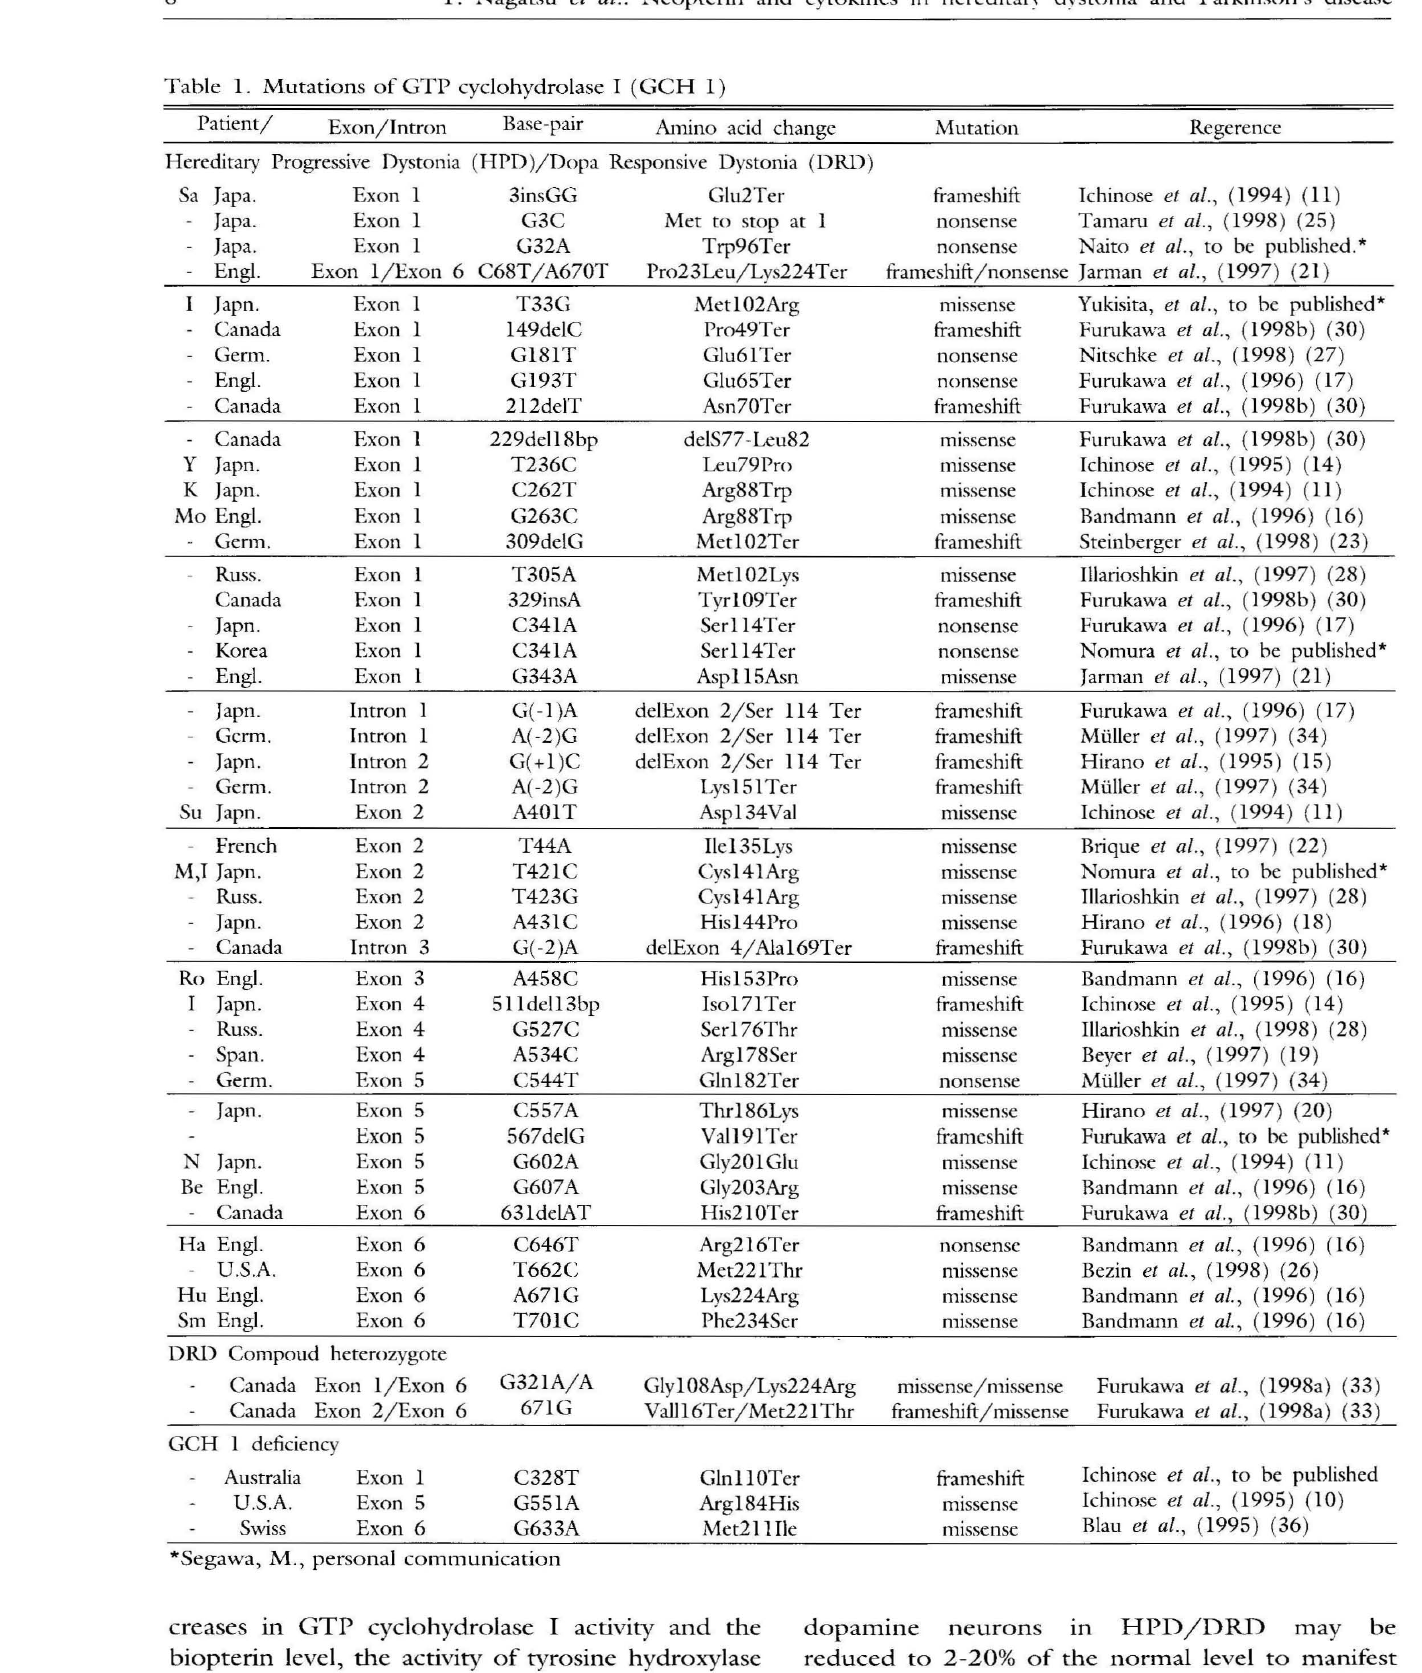
Table 1. M utations of GTP cyclohydrolase I (GCH 1) Patient/ Hereditary Progressive Dystonia (HPD)/Dopa Responsive Dystonia (DRD)